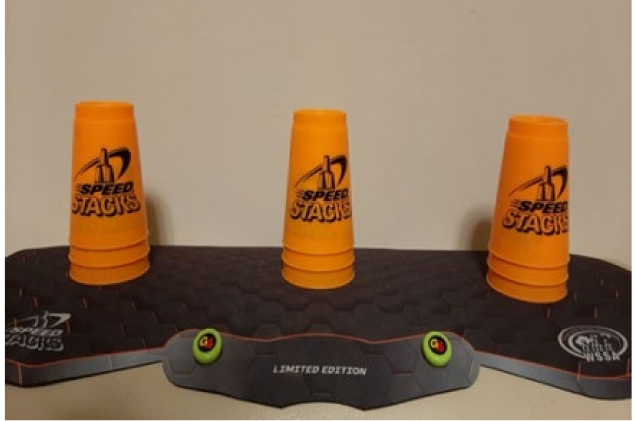
Figure 2. Start with three stacks of three cups.